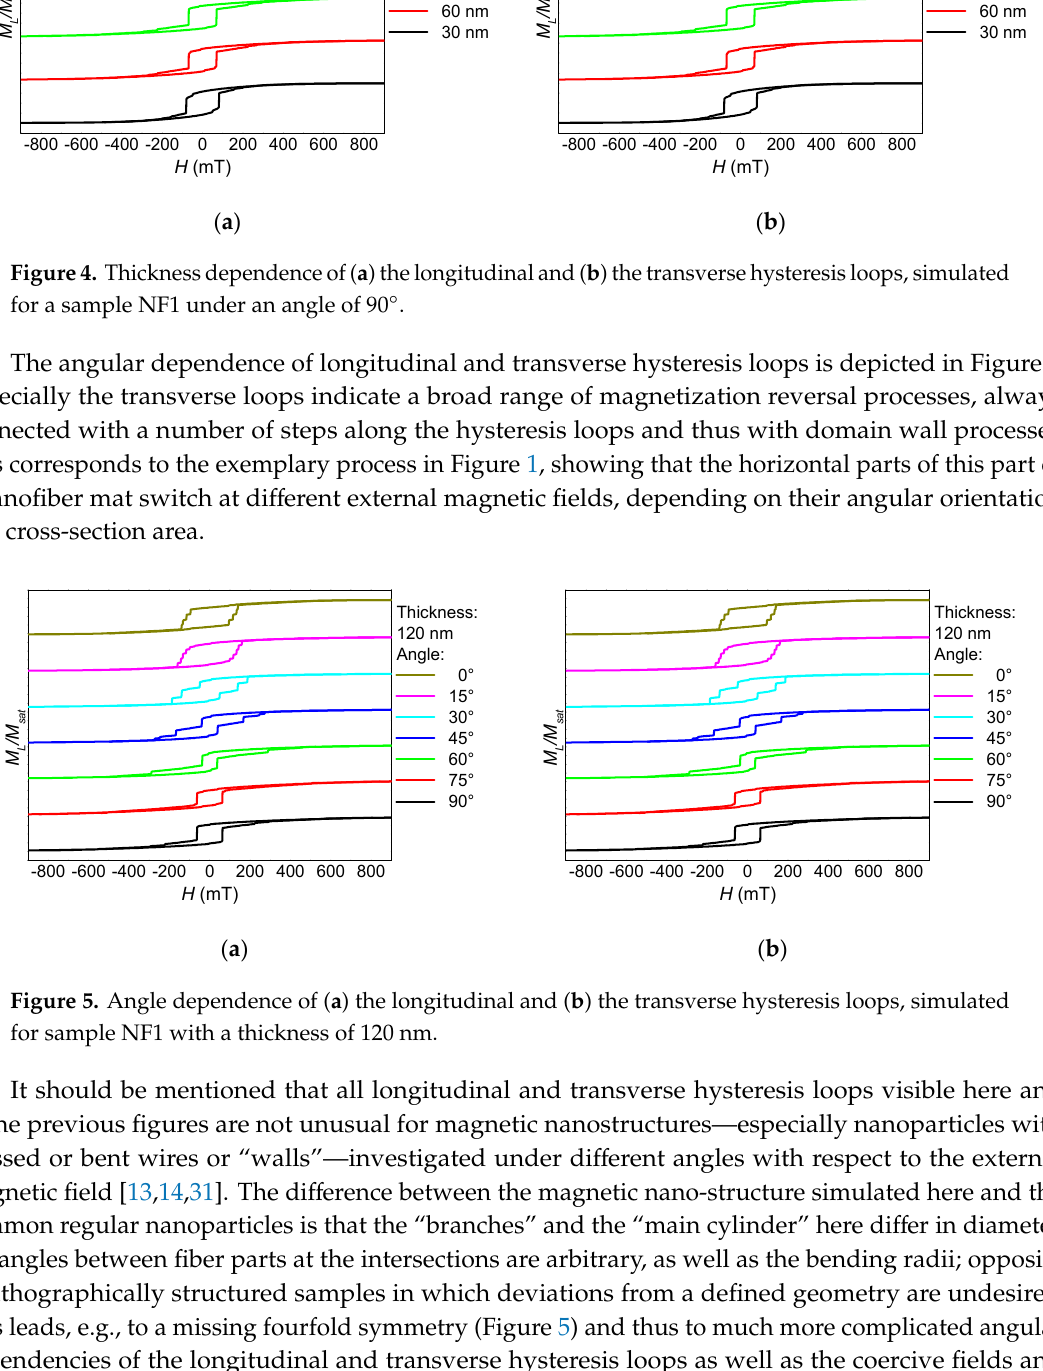
Figure 5. Angle dependence of ( a ) the longitudinal and ( b ) the transverse hysteresis loops, simulated for sample NF1 with a thickness of 120 nm.